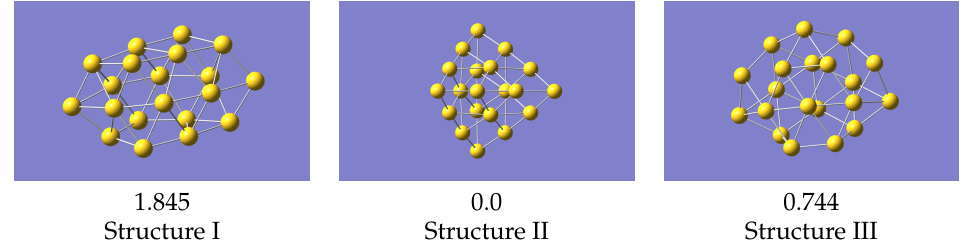
Figure 6. VASP optimised structures from a regular VASP geometry optimisation. Energies (in eV) given relative to the lowest energy